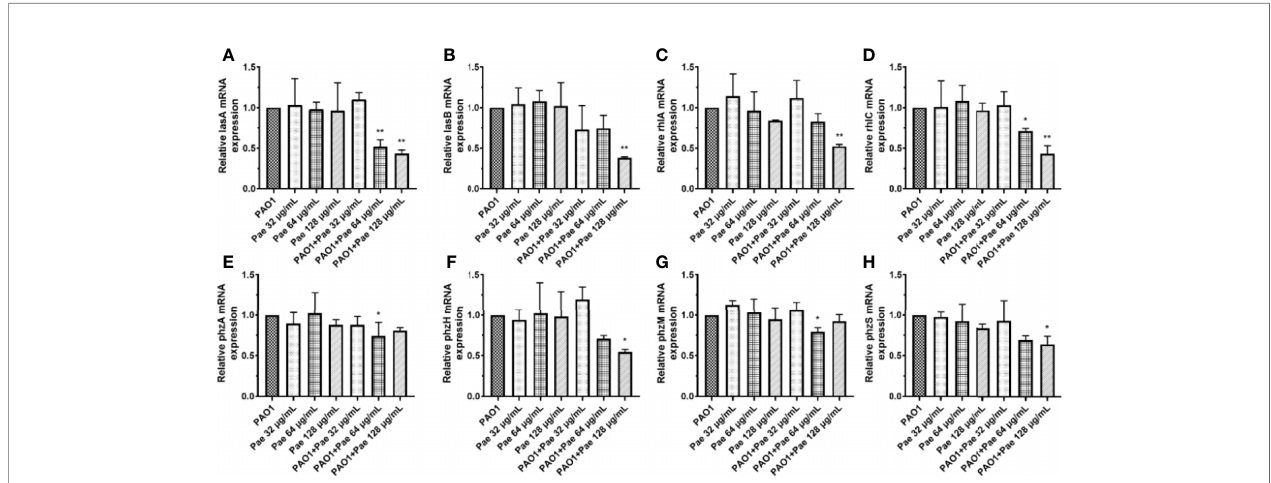
FIGURE 4 | Transcriptional levels of the virulence genes during P. aeruginosa infected macrophages (MOI = 100:1) following pretreatment and treatment with paeonol. (A) lasA, (B) lasB, (C) rhlA, (D) rhlC (E) phzA, (F) phzH, (G) phzM, (H) phzS, “ Pae 32 m g/mL ” , “ Pae 64 m g/mL ” , “ Pae 128 m g/mL ” indicate that RAW264.7 cells were treated with paeonol for 3 h before infection with PAO1. “ PAO1+Pae 32 m g/mL ” , “ PAO1+Pae 64 m g/mL ” , “ PAO1+Pae 128 m g/mL ” indicate that RAW264.7 cells were infected with PAO1 and treated with paeonol at the same time. The expression of mRNA was tested by RT-PCR. All data were expressed as means ± SD (n=3). * P < 0.05 or ** P < 0.01 vs the control group.